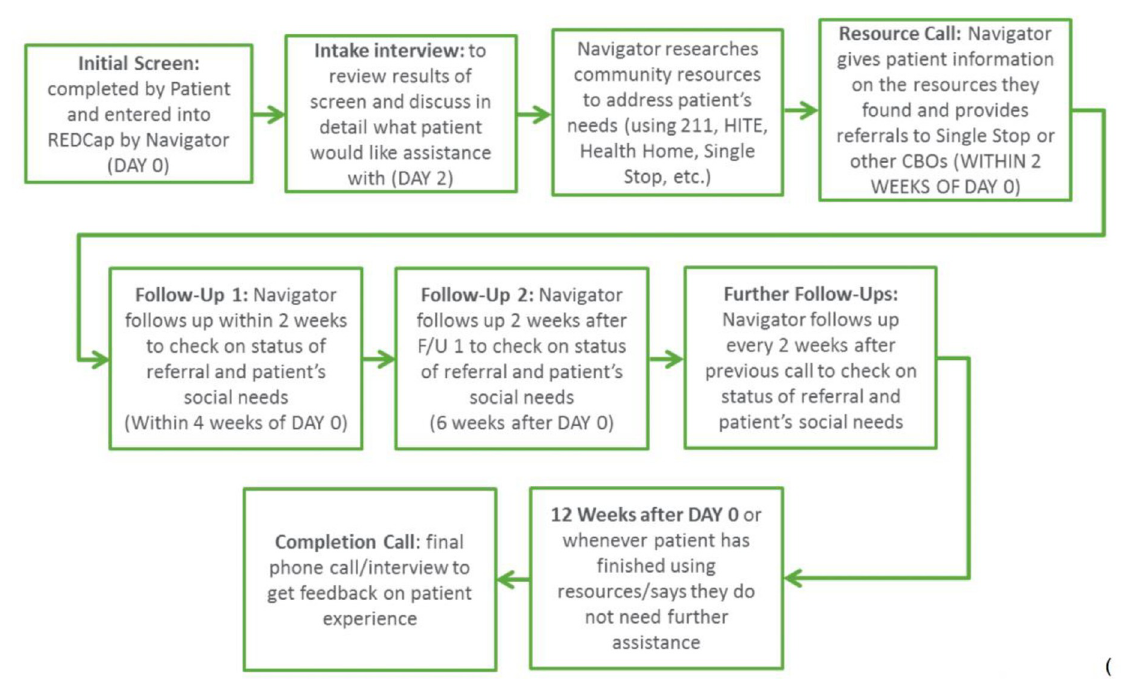
Fig 1. SHAPE SDH screening and referral program